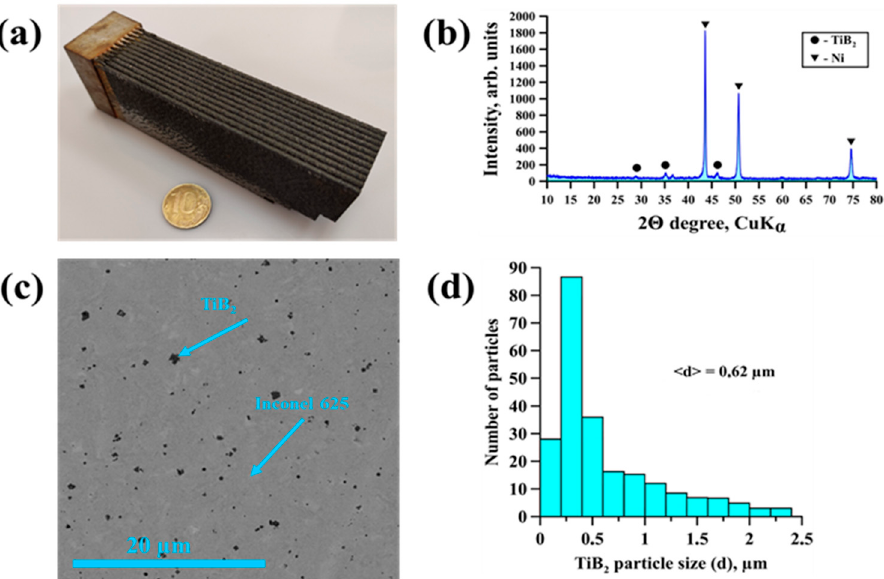
Figure 1. Appearance of a workpiece made of a high-temperature composite Inconel 625 + 5 wt.% NiTi–TiB 2 ( a ) alloy, X-ray and SEM images of the workpiece structure ( b , c ), histogram of the distribution of TiB 2 ceramic inclusions in the structure of the composite workpiece ( d ).